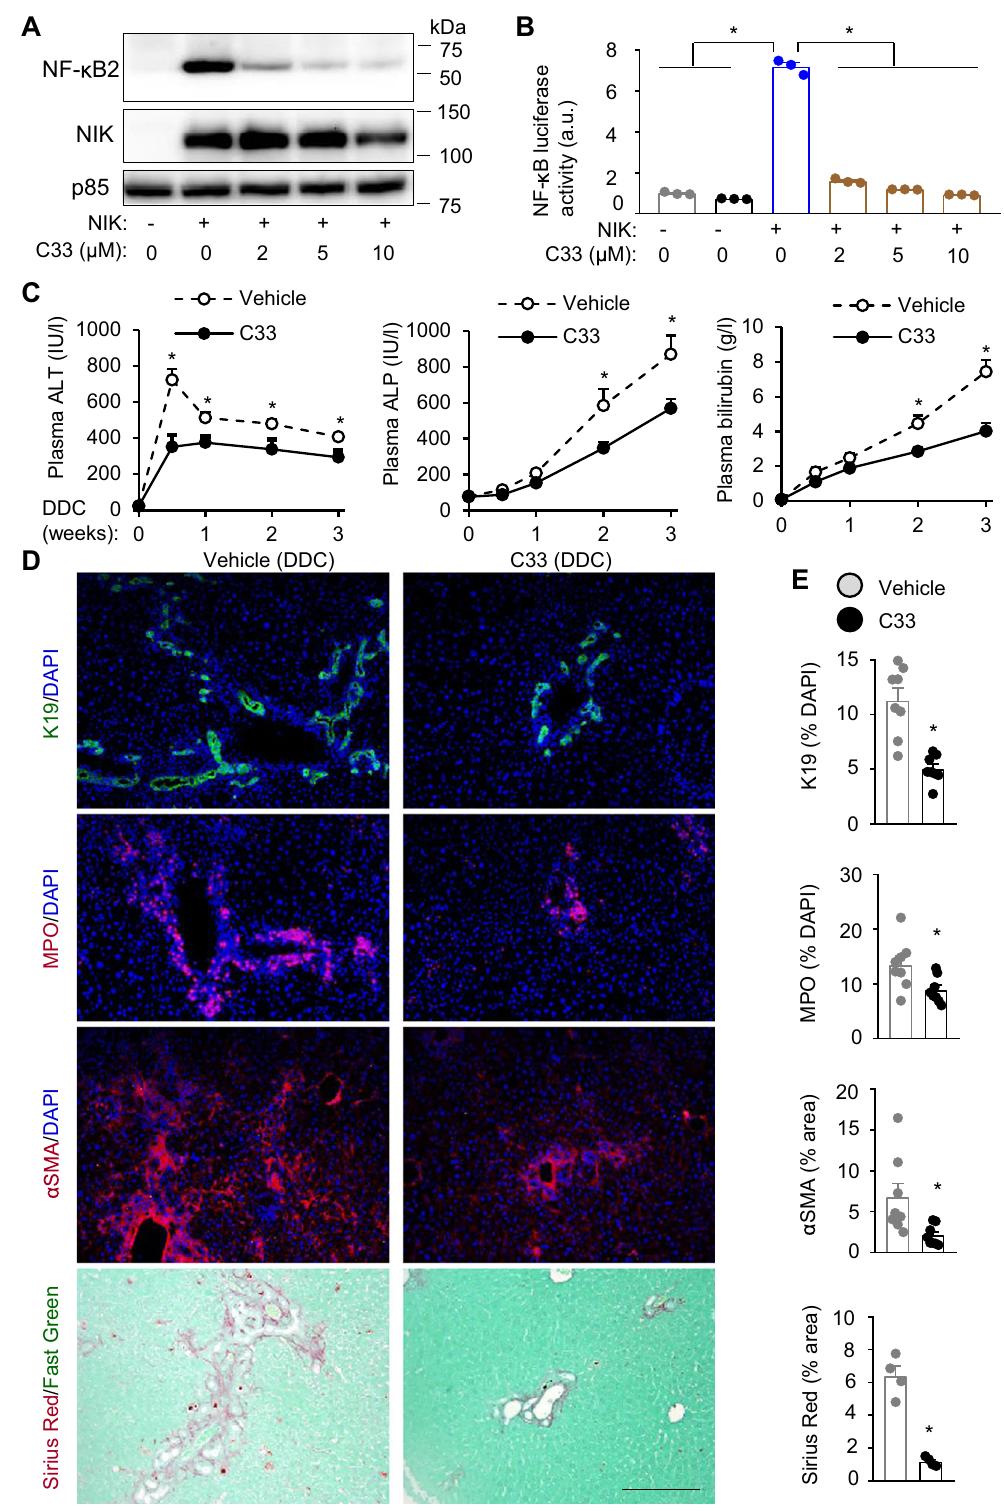
Fig. 8 | NIK inhibitor treatment ameliorates DDC-induced ductular reaction and liver injury. A HEK293 cells were cotransfected with NF- κ B2 and NIK expres- sion plasmids and treated with C33. Cell extracts were immunoblotted with anti- bodiestoNF- κ B2andNIK. B HEK293cellswerecotransfectedwithNF- κ Bluciferase reporterand NIKexpressionplasmidsandtreatedwithC33.Luciferaseactivitywas assessed 48h after C33 treatment ( n =3 repeats per group). C – E C57BL/6J males were treated with DDC and C33 for 3weeks. C Plasma ALT, ALP, and total bilirubin